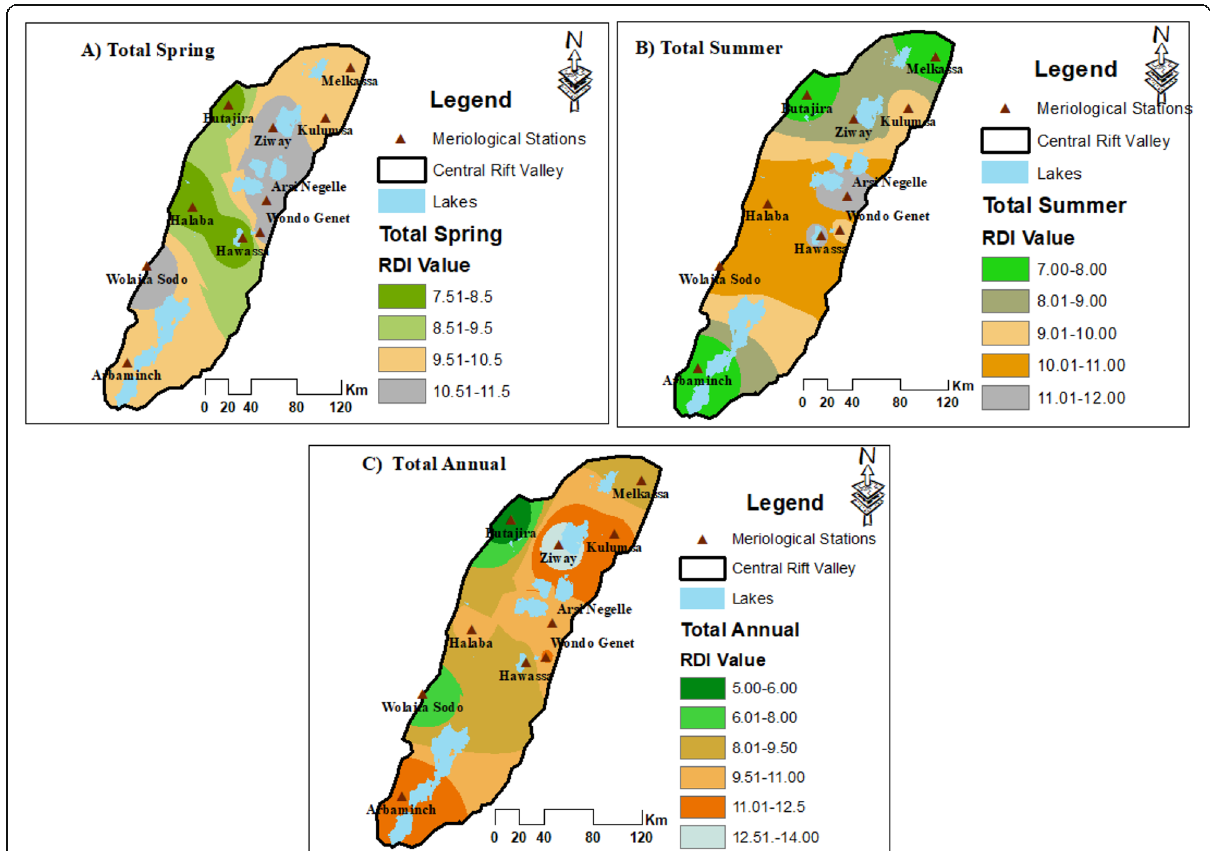
Fig. 10 Spatial distribution of total drought events in spring and summer seasons and at annual timescale in Lake's region of Ethiopian rift valley. a ) Total drought in spring. b ) Total drought in summer. c ) Total annual drought